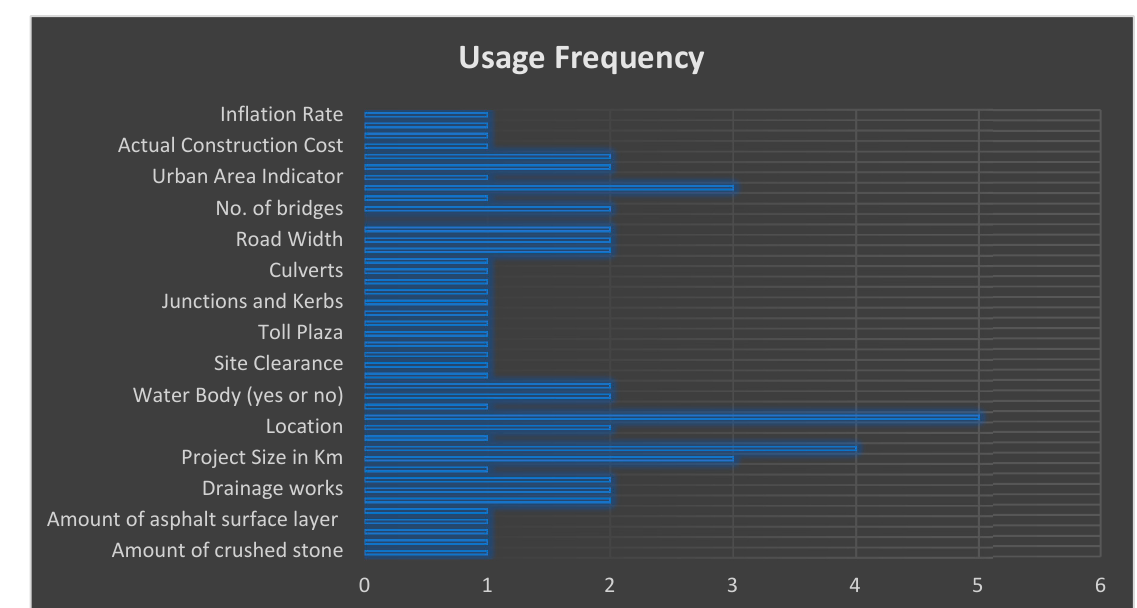
Figure 11. Usage frequency of input parameters for construction cost